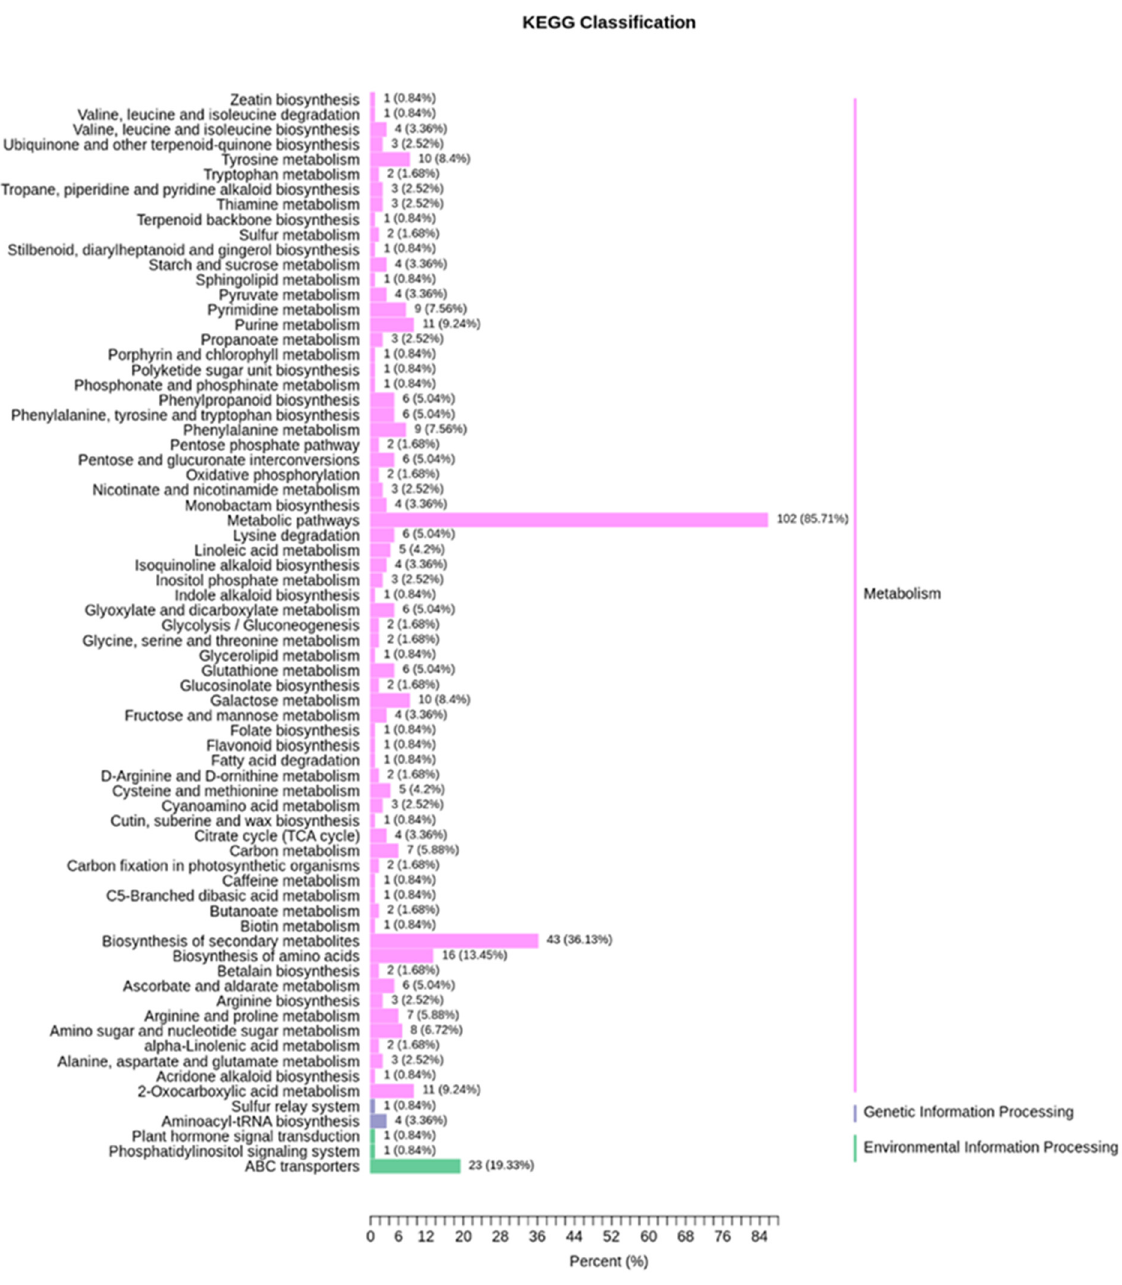
Figure 7. Comparison of KEGG metabolic pathway classification between CK and T groups.